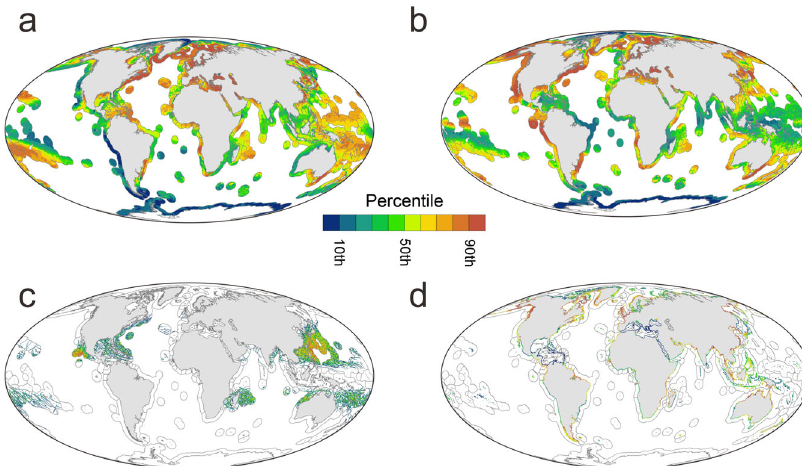
Fig. 2 Intensity of climate change hazards. Based on the percentiles associated with each hazard in coastal waters: a rate of change in sea-surface temperature (1982 – 2018), b cumulative intensity of marine heatwaves (1982 – 2018), c frequency of tropical storms (1980 – 2018), and d estimates of extreme sea levels associated to storm surges (1974 – 2014). Color categories associated with deciles with the most extreme (90th) corresponding to coastal hotspots for each of the four hazards (maps with the actual values of the hazards are provided in Supplementary Fig. 2). The maps were created using ArcMap